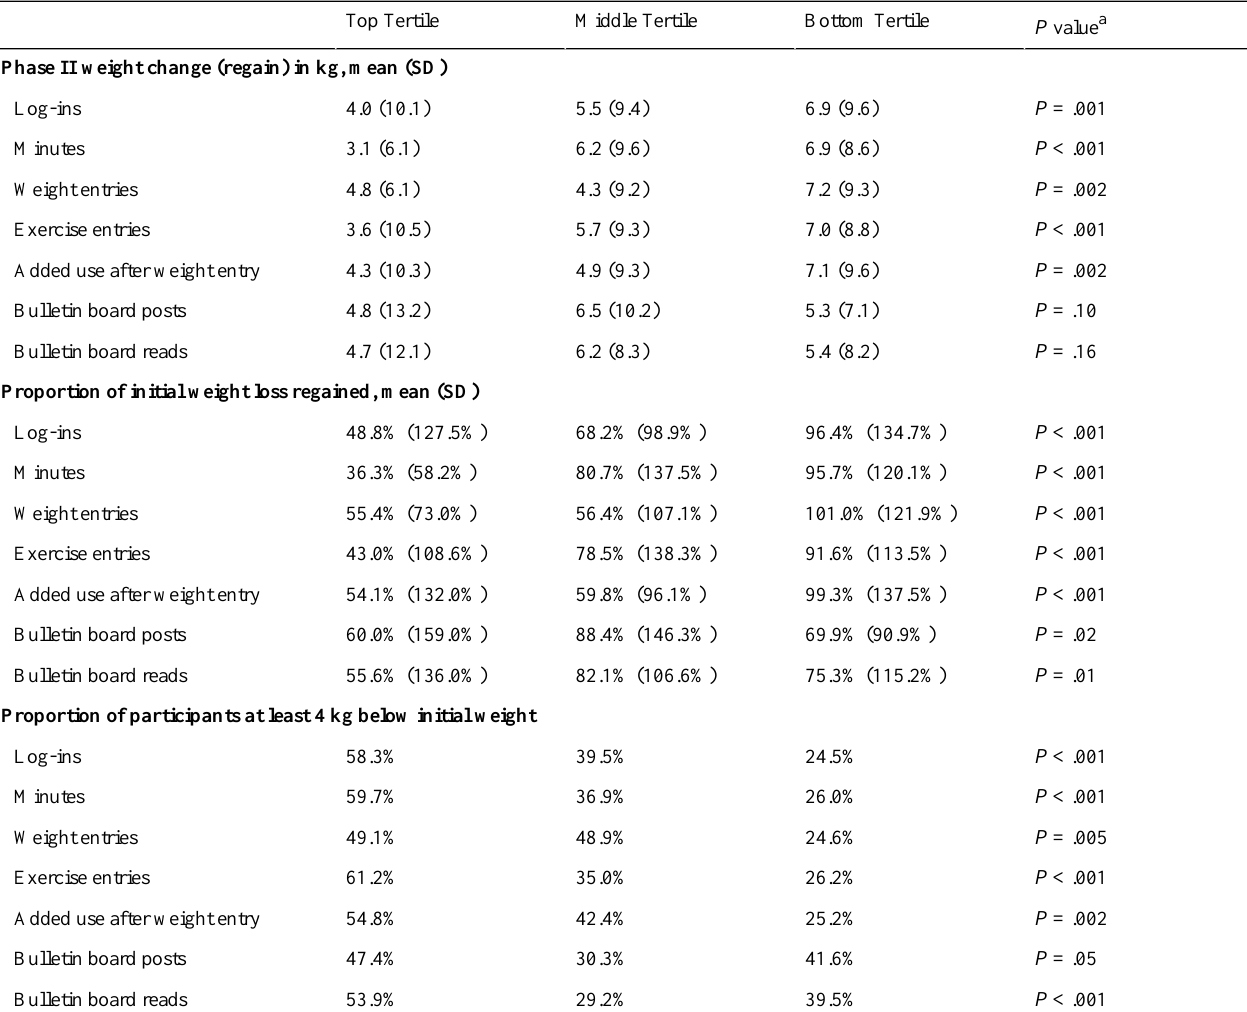
P value a Bottom TertileMiddle TertileTop Tertile